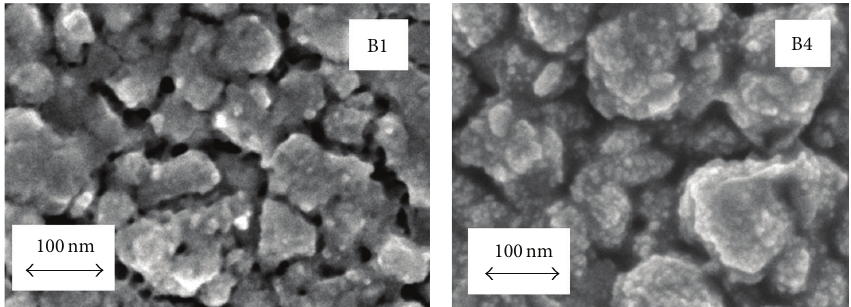
Figure 10: Surface morphology of sample B1 (as-grown) and B4 (annealed at 370 ∘